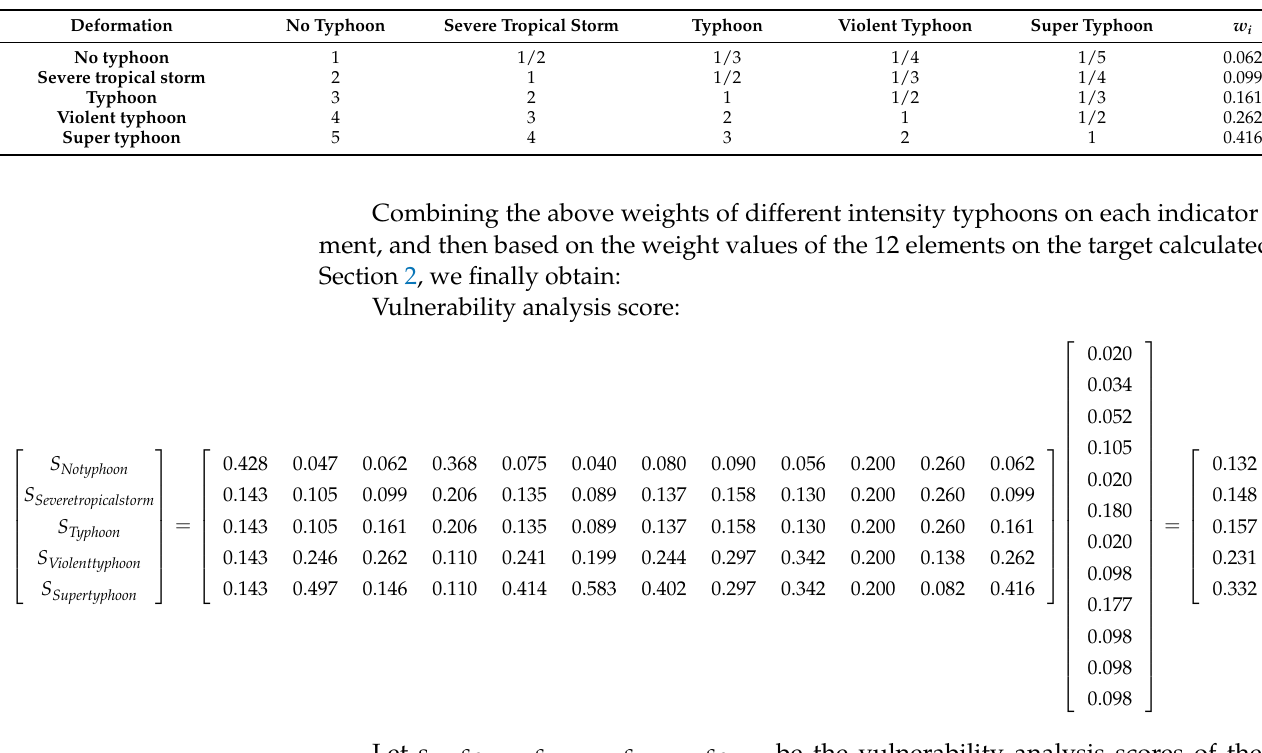
Table 14. Important degree judgment matrix of deformation under different typhoon